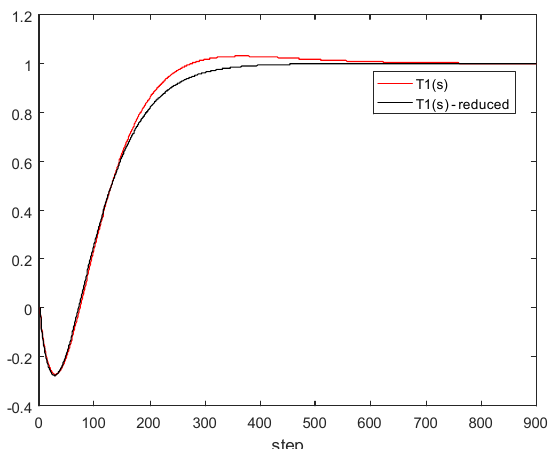
Figure 10. Comparison of original and T 1 and after order reduction (black line)—simulation of 900 time-steps.